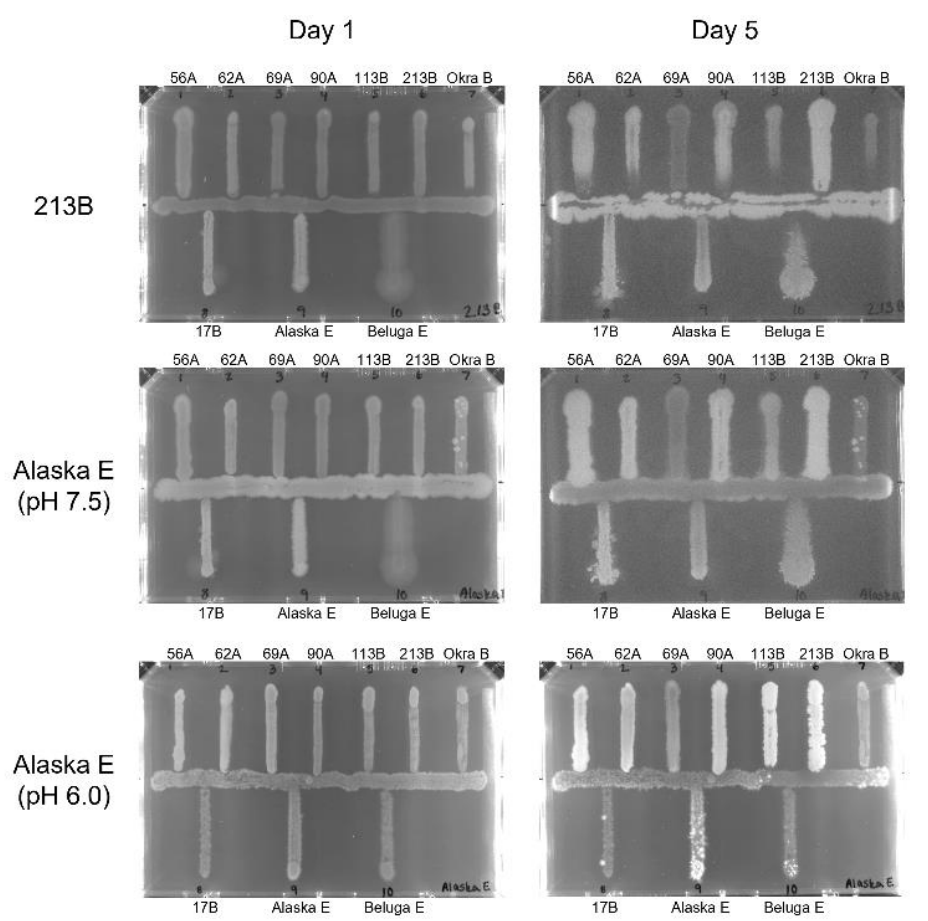
Figure 2. Growth inhibition patterns of C. botulinum strains. Representative inhibition plates with center indicator strain 213B on plates with pH 7.5 and Alaska E on plates with pH 7.5 and 6.0 on day 1 and day 5 of incubation.